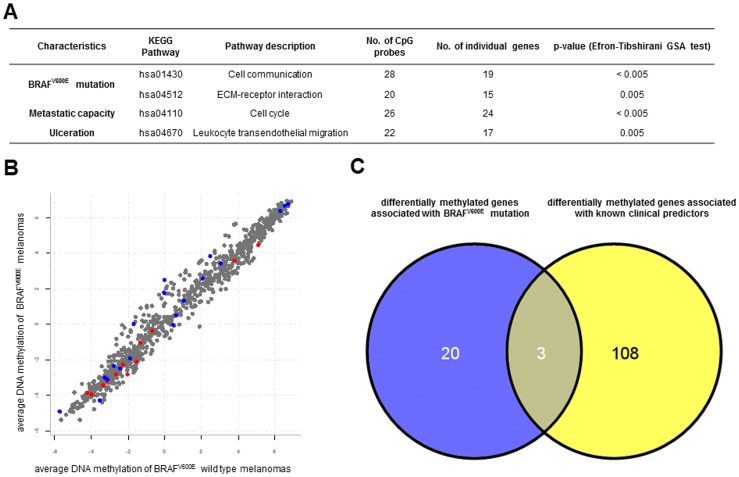
Differentially methylated gene sets between the BRAFV600E mutant and wild-type classes.(A) Differentially methylated gene sets between BRAFV600E mutant and wild-type, metastatic and non-metastatic, ulcerated and non-ulcerated classes according to the Kyoto Encyclopaedia of Genes and Genomes. (B) Average log-ratios of methylation intensities in BRAFV600E mutant and wild-type melanomas. Red indicates significant genes associated with ECM-receptor interaction and blue depicts significant genes on Cell communication pathway. (Eleven genes overlap between the ECM-receptor interaction and Cell communication.) (C) Venn diagram shows lack of overlap between differentially methylated genes associated with BRAFV600E mutation and the known clinical predictors as Breslow thickness, metastatic capacity, ulceration and histologic subtype.